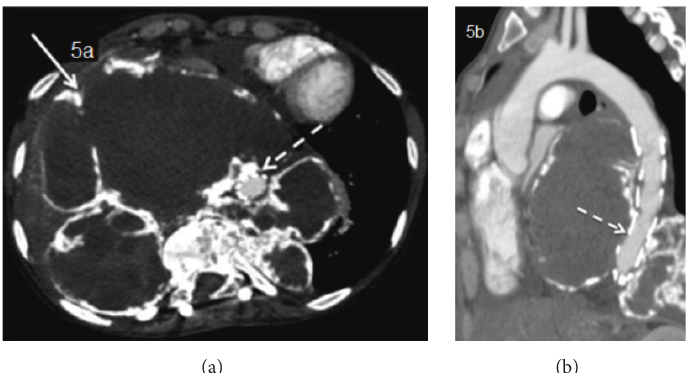
Figure 5: Postcontrast/arterial phase (a) and oblique reformatting (b) after successful placement of aortic endovascular stent graft and repair of the pseudoaneurysm.